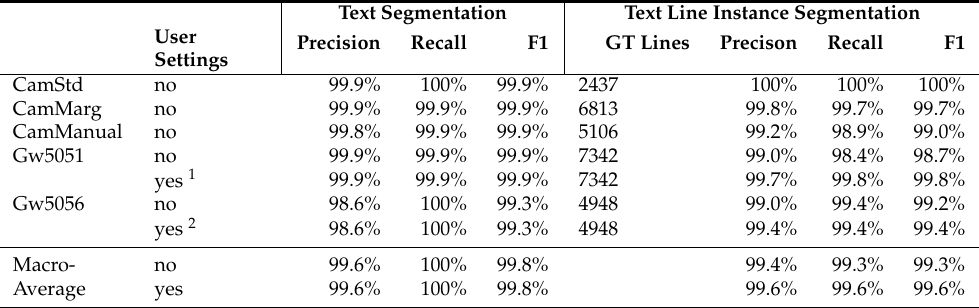
Table 3. Evaluation of the pixel-level text/non-text segmentation and line instance segmentation of our method on our evaluation datasets CamStd, CamMarg, CamManual, Gw5051, and Gw5056. 1 The user settings were set to the configuration: two-column layout, no marginalia, no dropped capitals, split of the top line into headline and header. 2 The configuration setting was: no dropped